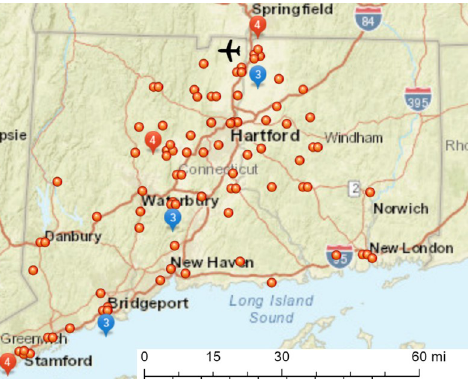
Fig 3. Geolocation of SARS-CoV-2 IgG+ subjects according to home zip code. The number of SARS-CoV-2 IgG + subjects per zip code was mapped based on home zip code. Hot spots with multiple cases (4 or 3)/zip code are highlighted, and include Stamford, the town just north of NYC, the north-central part of the state near the Hartford- Springfield International Airport, Bristol, Bridgeport and Waterbury.